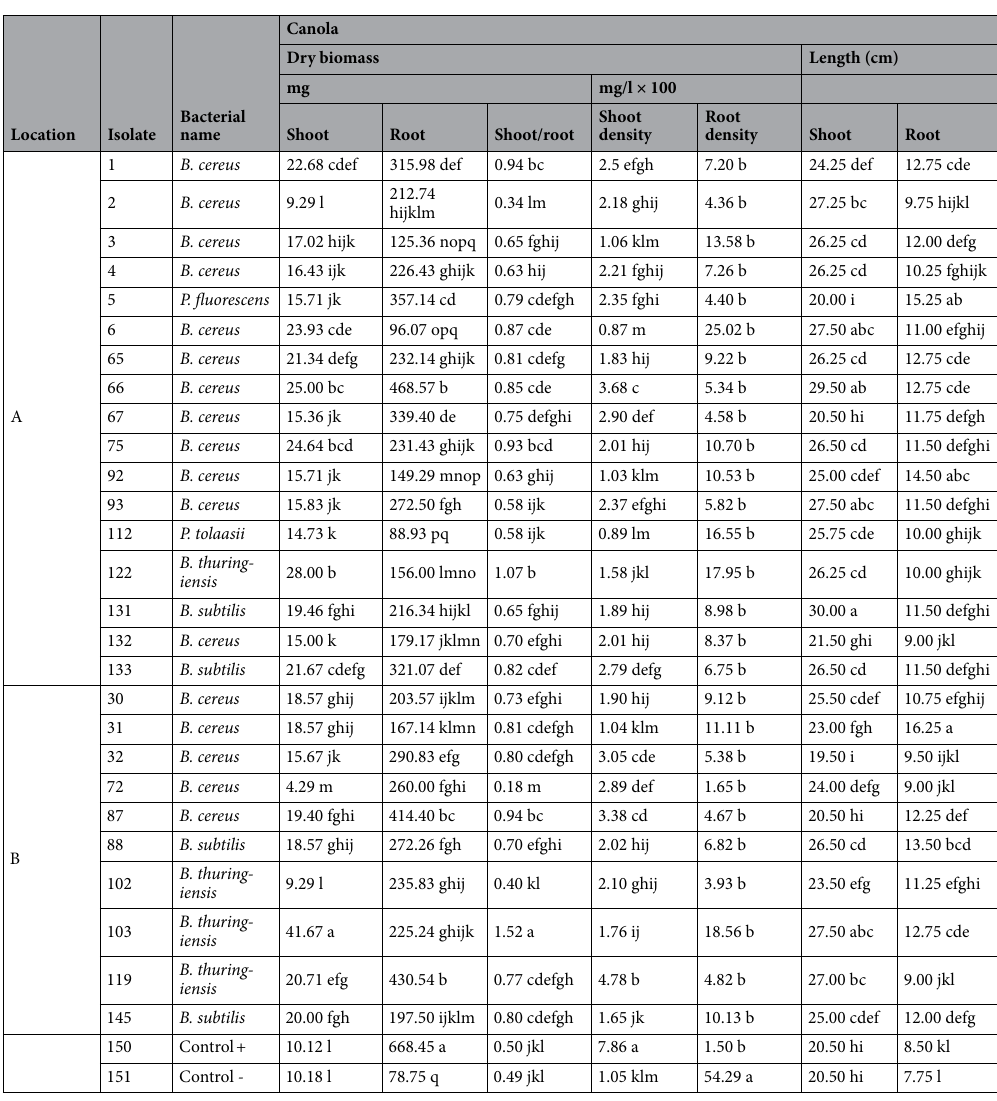
Table 5. Influence of soil isolates on growth parameters after 21 days of assessment on canola plants. LSD p = 0.01 value for the parameters on canola, respectively: 0.001935741, 0.009622568, 0.01059692, 0.08514634, 1.476113, 1.482904, 2.118454; A and B were indicated sampling